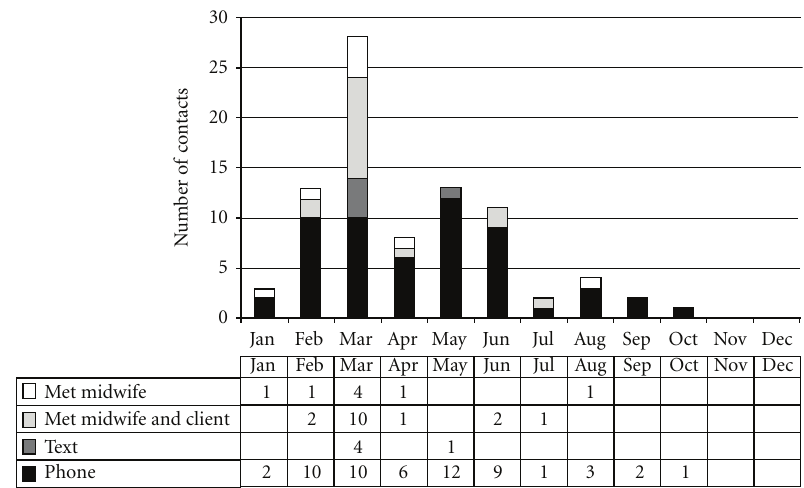
Figure 1: Number, type, and frequency of contacts between mentors and new graduates over one